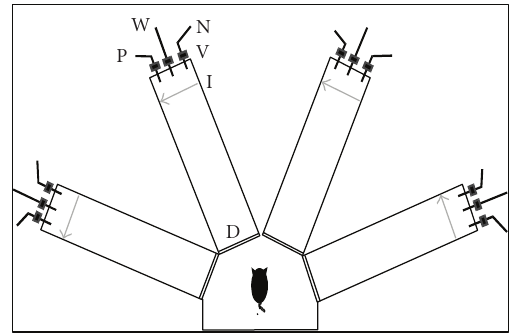
Figure 1: Schematic description of the olfactory maze. Protocols for trained and pseudotrained rats are similar: an electronic “start” command randomly opens two out of eight valves (V), releasing a positive-cue odor (P) into one of the arms and a negative-cue odor (N) into another. Eight seconds later, the two corresponding guillotine doors (D) are lifted to allow the rat to enter the selected arms. Upon reaching the far end of an arm (90 cm long), the rat body interrupts an infrared beam (I, arrow) and a drop of drinking water is released from a water hose (W) into a small drinking well (for trained rats, only if the arm contains the positive-cue odor; for pseudotrained rats, in random arms). A trial ends when the rat in- terrupts a beam, or after 10 seconds, if no beam is interrupted. A fan is operated for 15 seconds between trials, to remove